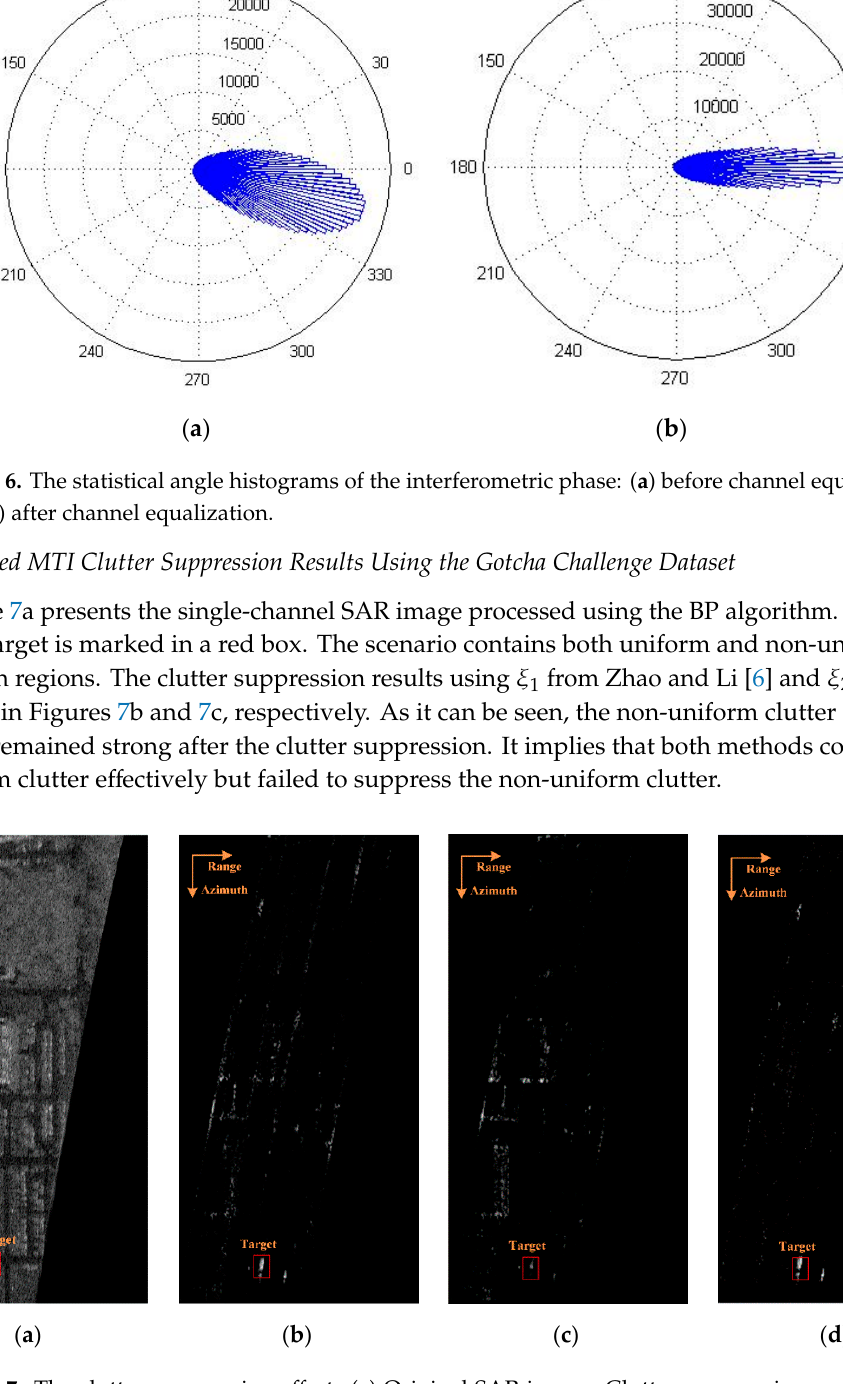
Figure 7. The clutter suppression e ff ect. ( a ) Original SAR image. Clutter suppression results with ( b ) ξ 1 , ( c ) ξ 2 , and ( d ) W DPCA